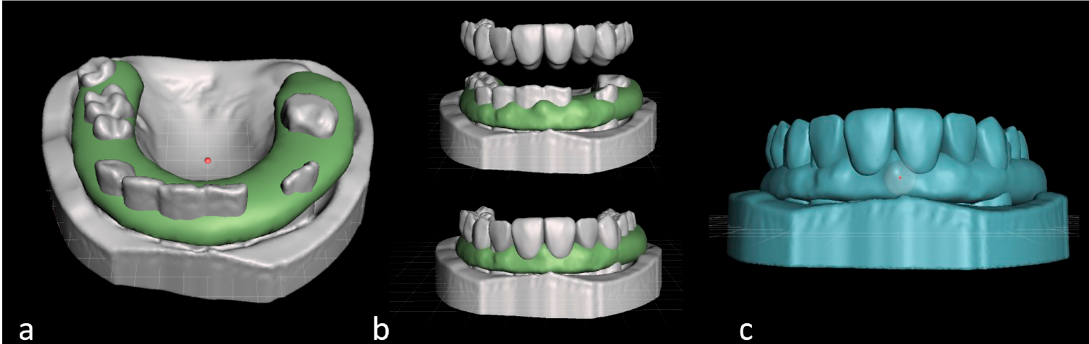
Figure 6. Designing the gingival portion of the overlay template. ( a ) A plane appended to the world origin of the modeling software. Using the unselected maxillary digital cast as reference, an approximation of the arch shape was selected on the appended plane. ( b ) Arch shape transferred to the appended plane. ( c ) Displacement of the selected area in the Y+ direction to create a gingival “horseshoe”. Note the softened contours achieved using the “Smooth” function.